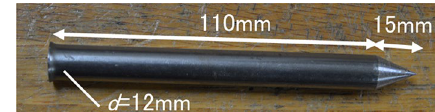
Fig. 2 Schematic illustration of the 12 mm